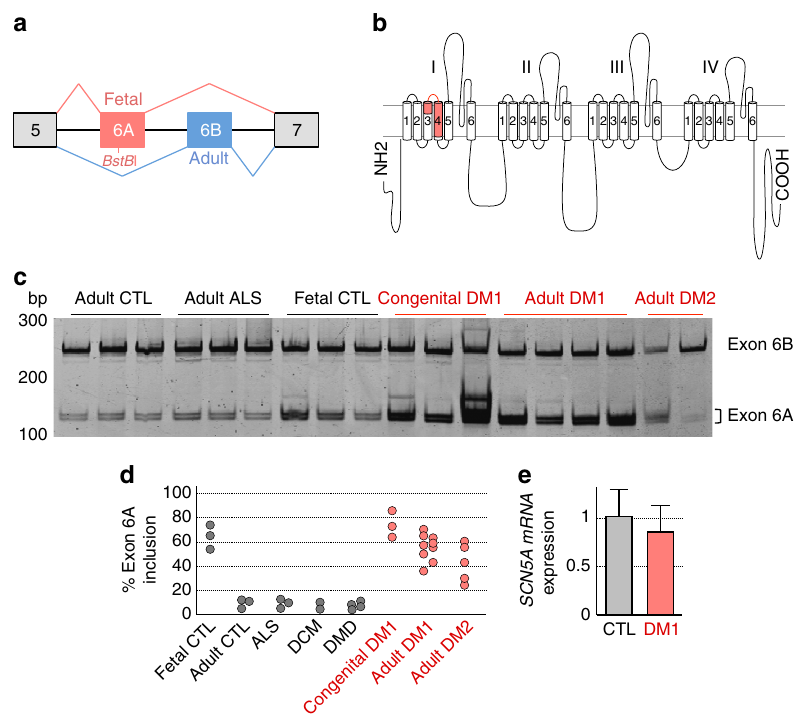
Figure 3 | Splicing of SCN5A exon 6A is altered in DM heart samples. ( a ) Schematic representation of mutually exclusive exons 6A and 6B of SCN5A . SCN5A mRNA includes exon 6A (red) in fetal heart, while SCN5A mRNA expresses exon 6B (blue) in adult heart. ( b ) Schematic representation of SCN5A topology expressing exon 6A (red). Exons 6A or 6B encodes part of segment 3, connecting loop between S3 and S4 and most part of the voltage-sensitive segment 4 of domain 1 of the sodium channel SCN5A. ( c ). Representative BstB I-digested RT–PCR analysis of endogenous SCN5A mRNA from human heart samples of normal adult (CTL), adult ALS, non-DM fetuses (20, 24 and 35 weeks), congenital DM1 fetuses (CDM1 of 22, 25 and 28 weeks), adults DM1 and DM2 individuals. Molecular size marker is indicated in bp. ( d ) Graphical representation of RT–PCR analysis depicting the percentage of SCN5A mRNA including exon 6A in left ventricular heart samples from fetal and adult control, ALS, DCM, DMD, CDM1 and adult DM1 and DM2 individuals. ( e ) Graphical representation of quantitative real-time RT-qPCR depicting the mRNA expression of SCN5A relative to RPLP0 in control normal adults ( n ¼ 5) versus adult DM1 ( n ¼ 5) heart samples. Bars indicate s.e.m. bp, base